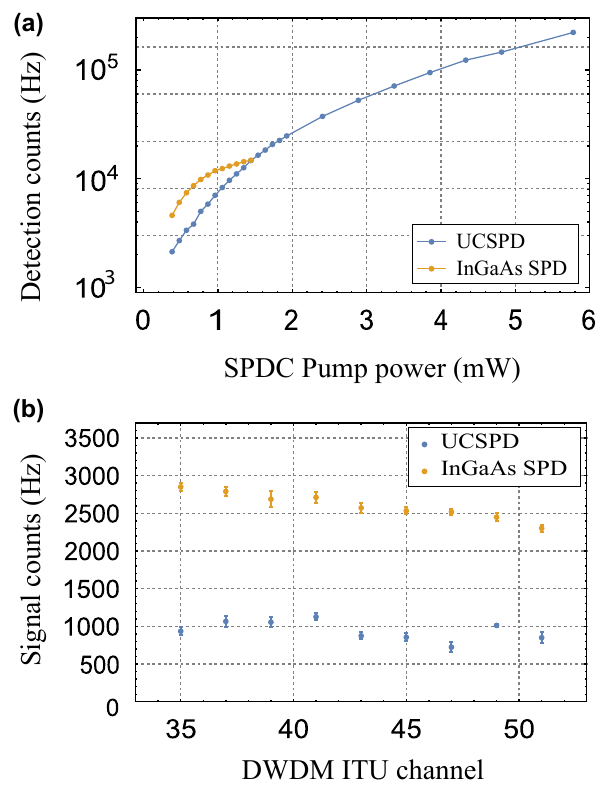
Figure 10: Up-conversion single-photon detector performance test results compared to the conventional InGaAs SPD. (a) Saturation limit measurement result. (b) Signal counts measurement result (signal counts = total counts − dark